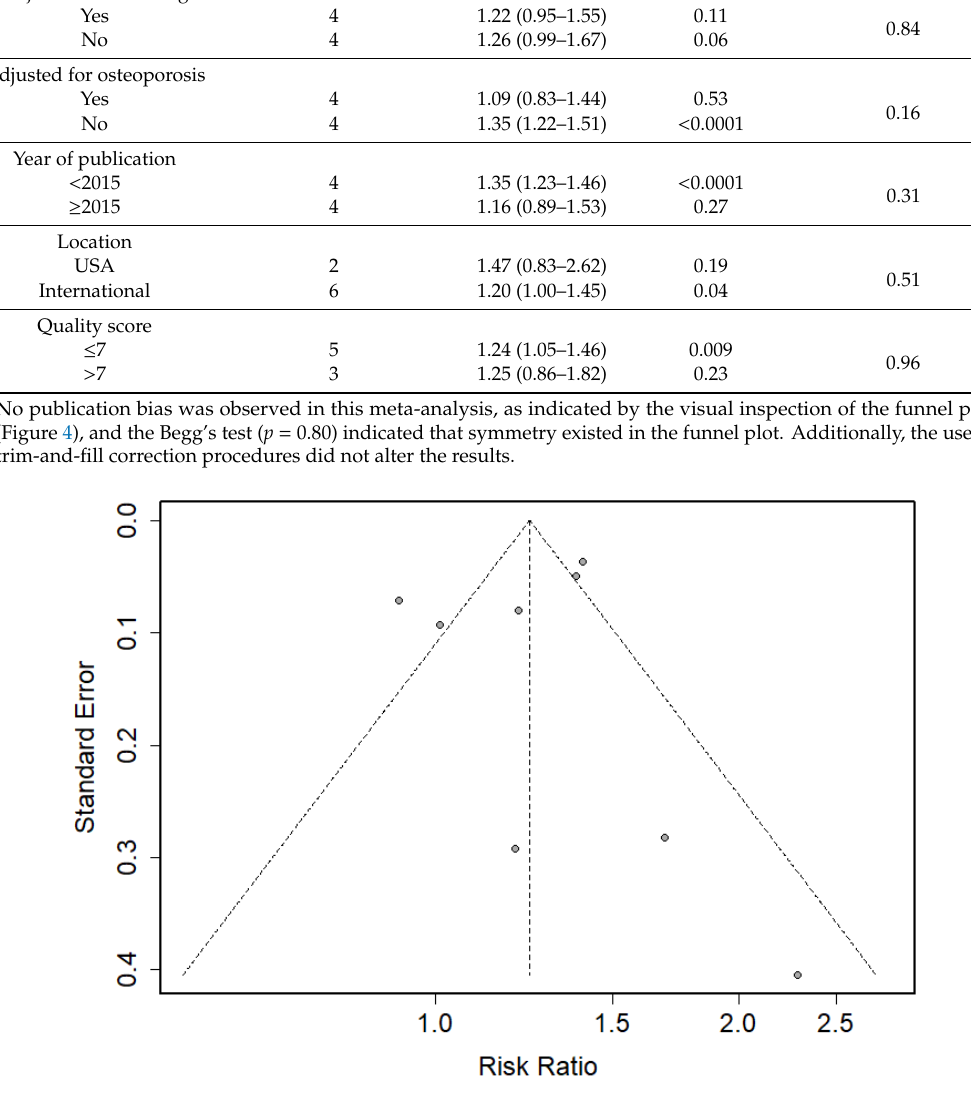
Figure 4. Funnel plot of the risk ratio vs. the standard error. Data were analyzed using the frequentist meta-analysis meta-analysis approach.